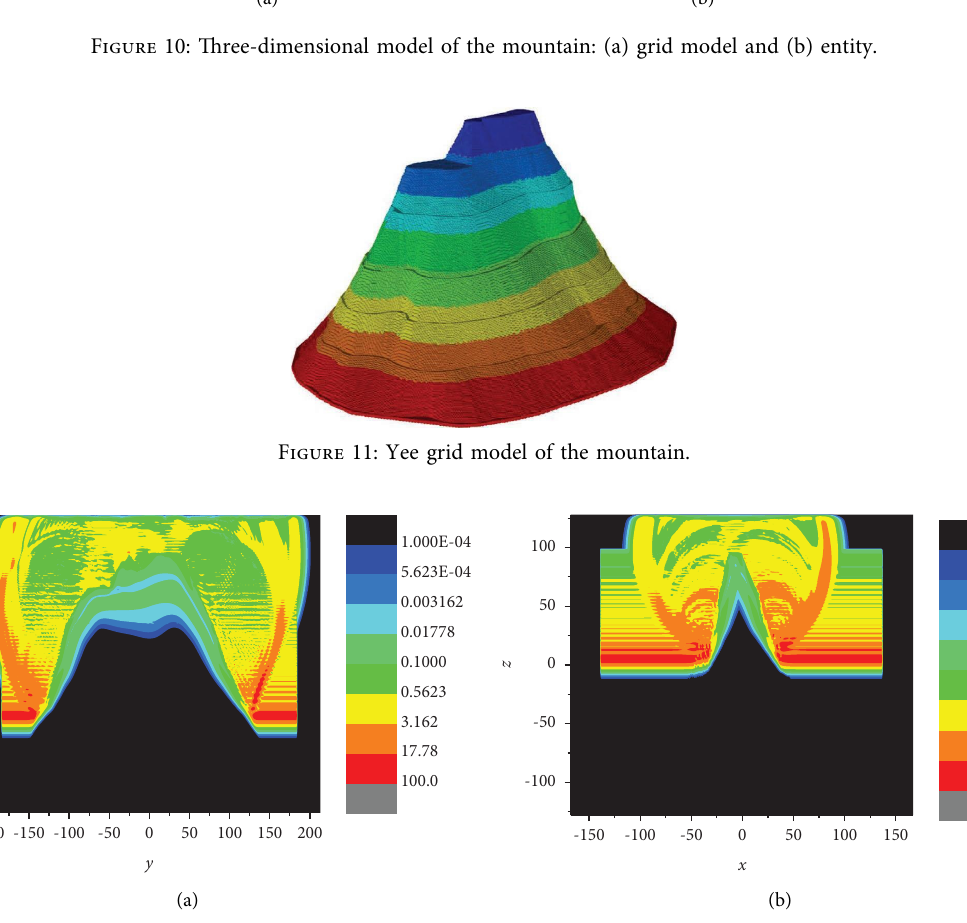
Figure 12: Electric feld distribution map of the mountain section: (a) yoz cross-section and (b) xoz cross-section.